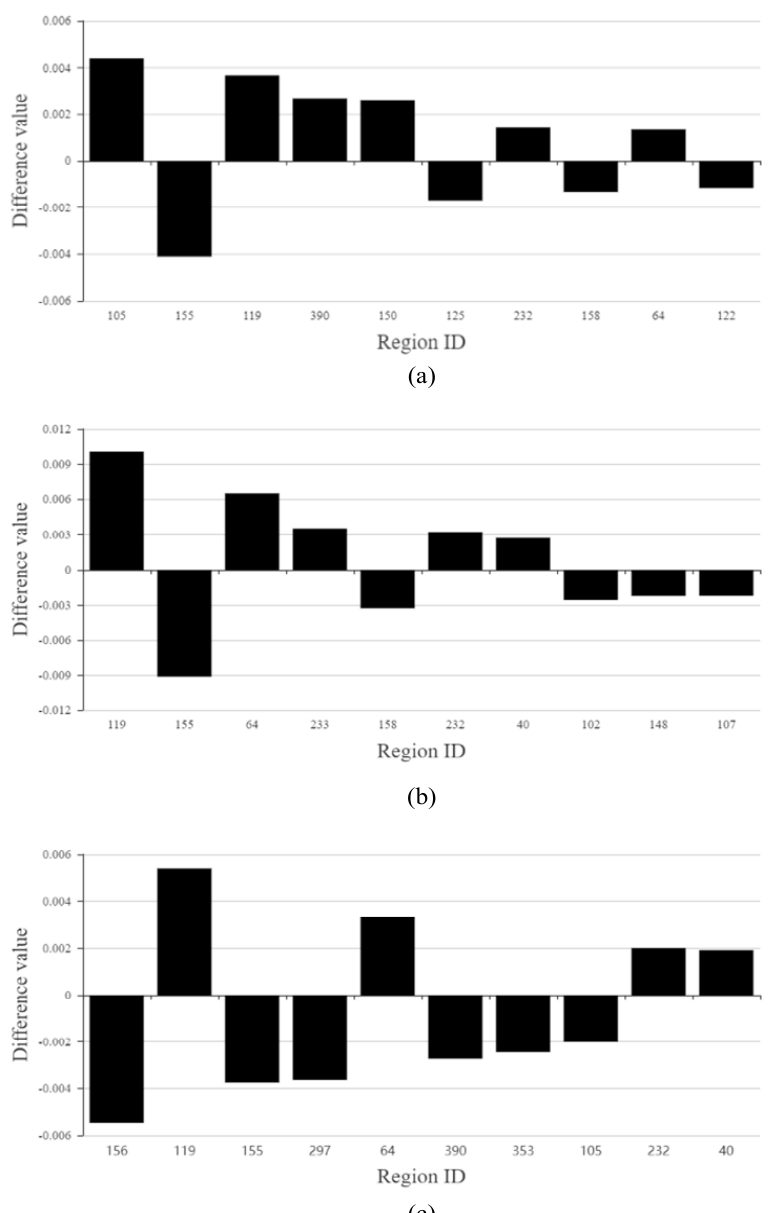
Figure 8. The top 10 functional regions with the largest values in ( a ) V 2 ( b ) V 3 and ( c ) V 4 .